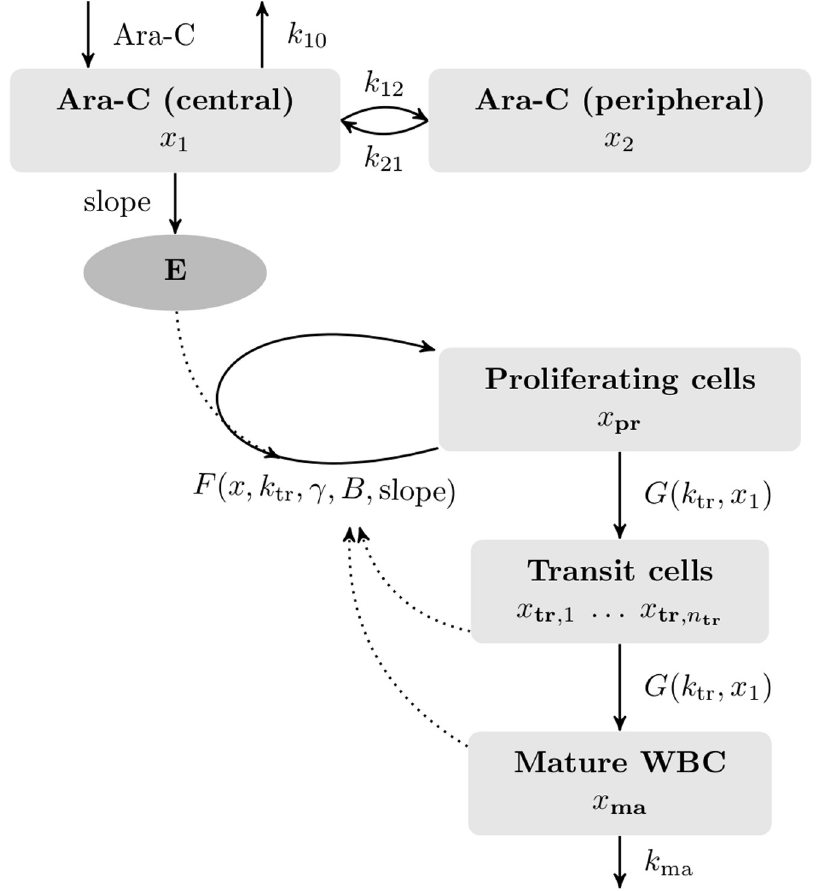
Fig 1. Schematic model from which all mathematical models were derived. We assumed clustering of cells and cytarabine (Ara-C) concentrations in compartments with identical properties. White blood cell (WBC) differentiation is represented by a proliferating compartment x pr , a number n tr of transit compartments x tr with different levels of maturation, and a compartment x ma with mature, circulating WBCs. Cells mature with a maturation rate G . Mature cells x ma die by apoptosis with a death rate of k ma . The pharmacodynamic effect of Ara-C is described as a log-linear function E targeting the proliferating cells in the bone marrow. It depends on the concentration x 1 of Ara-C in an assumed central compartment including the circulating blood. The proliferation rate F of x pr models the replication speed of proliferating progenitor cells. Modelling assumptions were incorporated by choosing different functions F and G (compare Table 1). The estimated model parameters used for personalisation were B , slope, k tr , γ , and initial conditions.